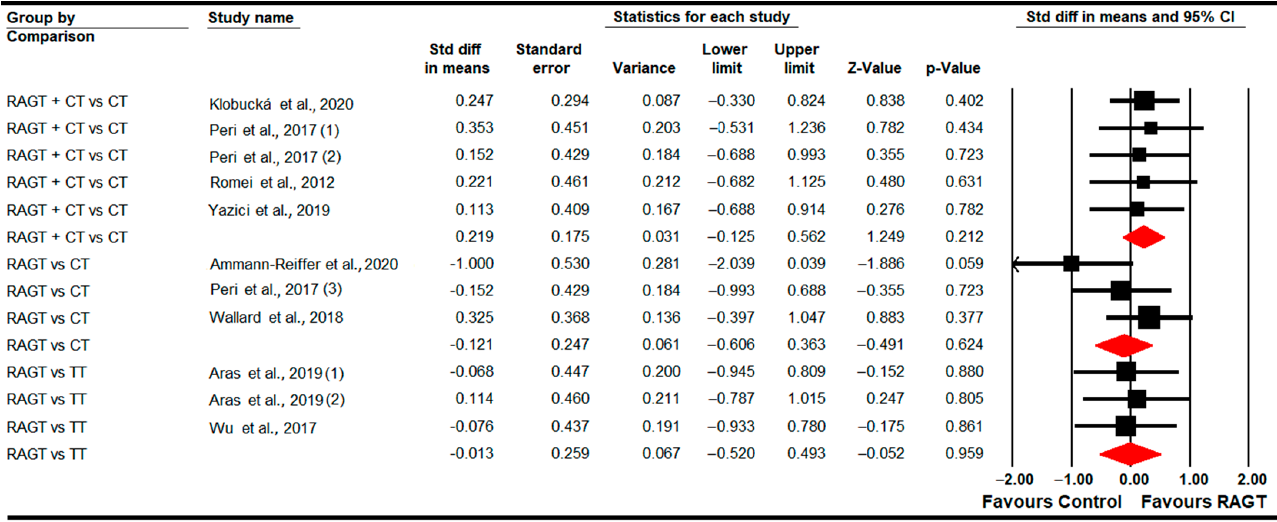
Figure 8. Forest Plot of Standing Ability (Post-Intervention Assessment)